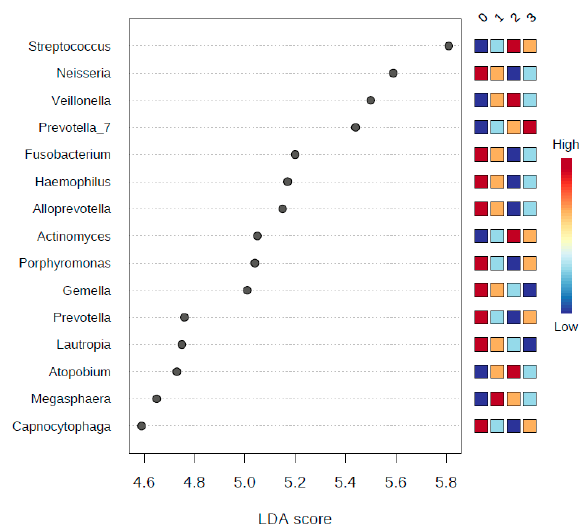
Figure 7. A plot of the LDA scores of the top 15 genera showing statistically significant differences between smokers and non-smokers. LDA scores on the x -axis and genera on the y -axis. The color-coding in the squares of the right side of the plot refers to the cumulative abundance of each genus in each binned group, where red means high cumulative abundance and blue means low cumulative abundance.